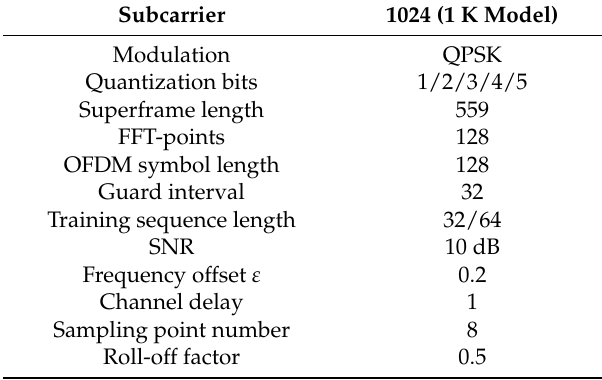
Table 1. Simulation system parameters. QPSK—quadrature phase shift keying; FFT—fast Fourier transform; OFDM—orthogonal frequency division multiplexing; SNR—signal-to-noise ratio.